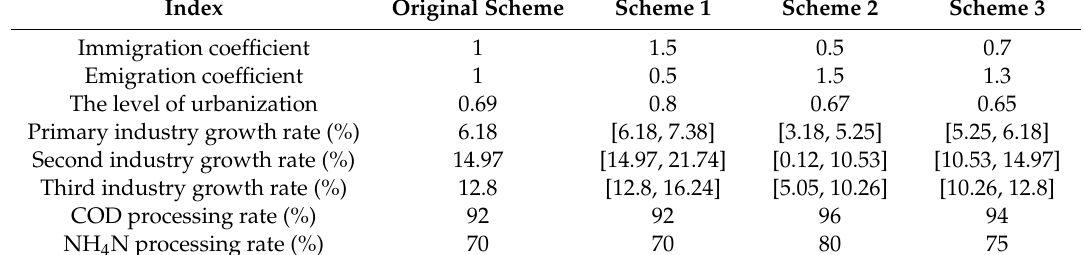
Table 6. Parameter settings for four scenarios after uncertainty analysis.